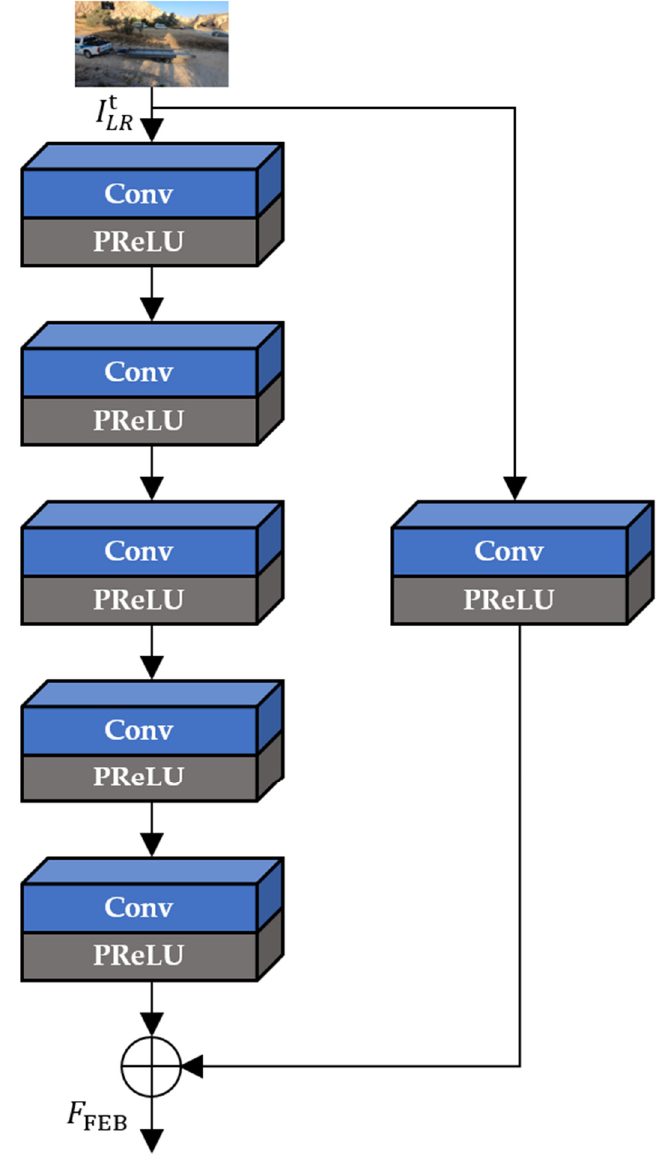
Figure 6. The architecture of FEB.